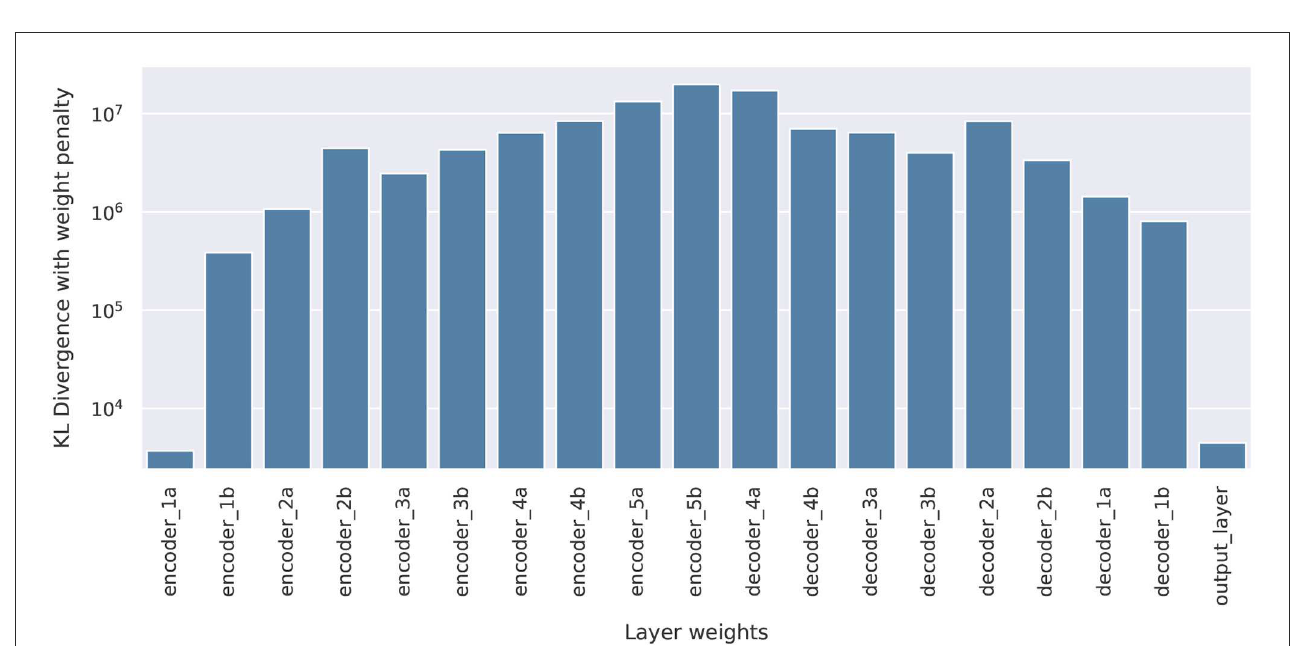
FIGURE8 Normalized KL D norm , for all 19 pBNNs each built with Bayesian inference on one of the layers in the U-Net.